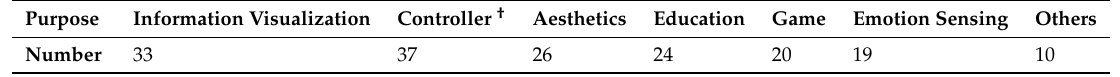
Table 3. Purpose of tangible light in the review